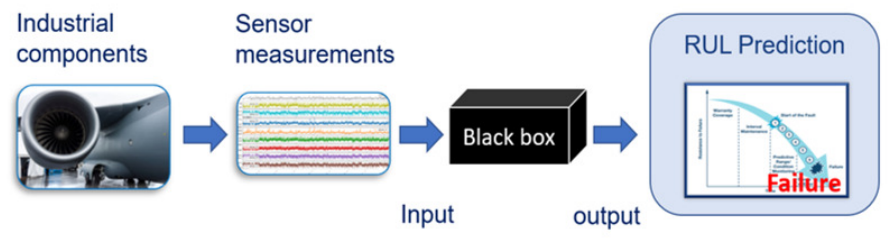
Figure 1. Flow chart of a data-driven RUL prediction